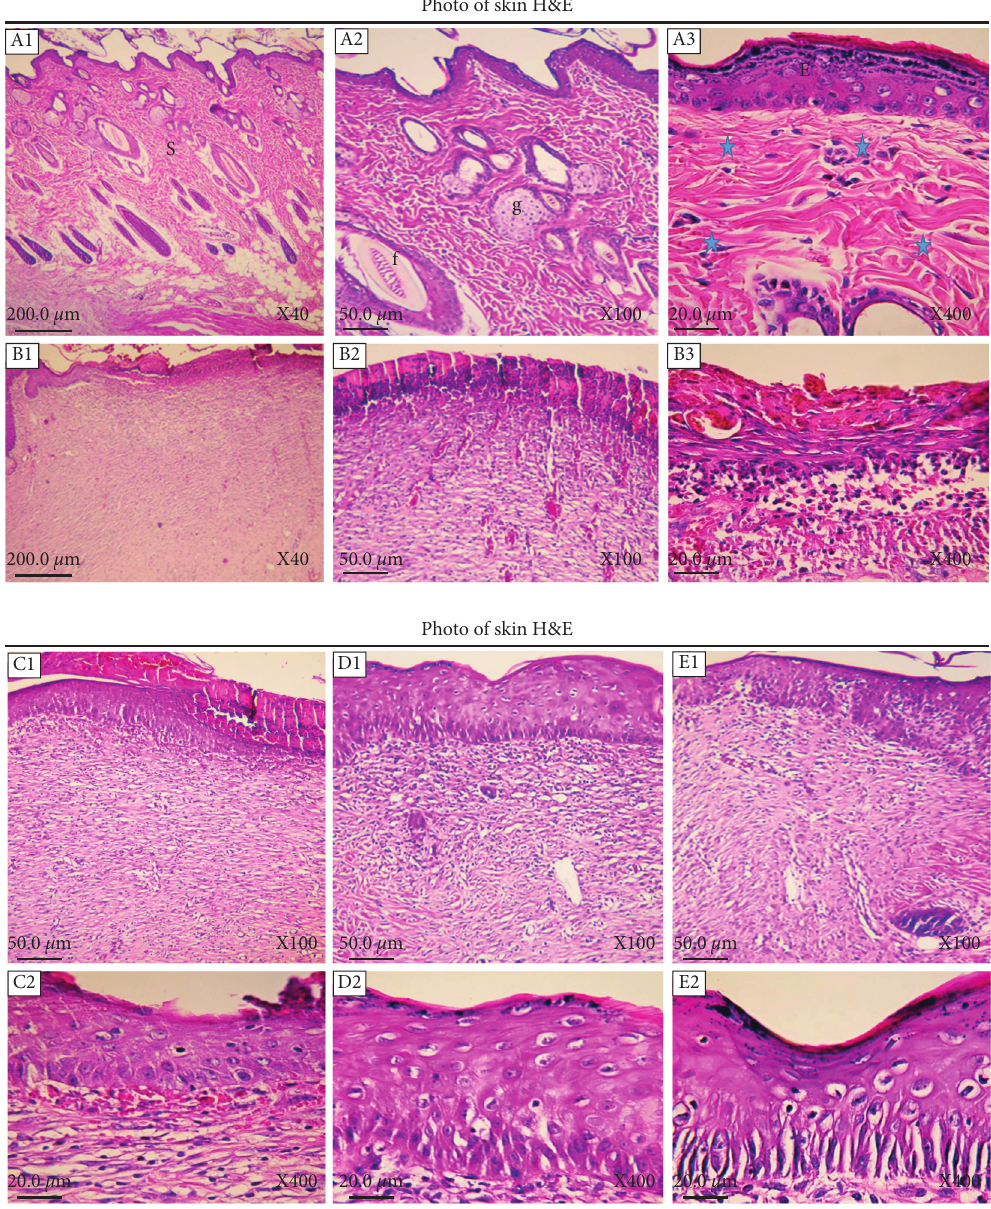
Figure 3: Histopathological evaluation of skin. (A1–A3) Normal healthy skin is a thick tissue (S) anatomically comprising two main segments of the epidermis and dermis. The epidermis consists of a keratinized stratified squamous epithelium (E), while the dermis is a connective tissue with different appendages including hair follicles (f), fat glands (g), and a variety of cells and regular connective tissue arrangements (asterisk). (B1–B3) × 40, × 100, and × 400 magnifications of skin tissue sections of the negative control group, respectively. (C1, C2) × 100 and × 400 images of skin tissue from the 10% PPE-treated group. (D1, D2) × 100 and × 400 magnifications of skin tissue from the 20% PPE-treated group. (E1, E2) × 100 and × 400 images of the phenytoin-treated